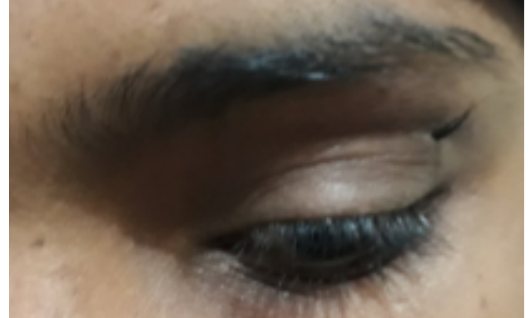
Fig 2. Ectopic cilia on left upper eyelid on